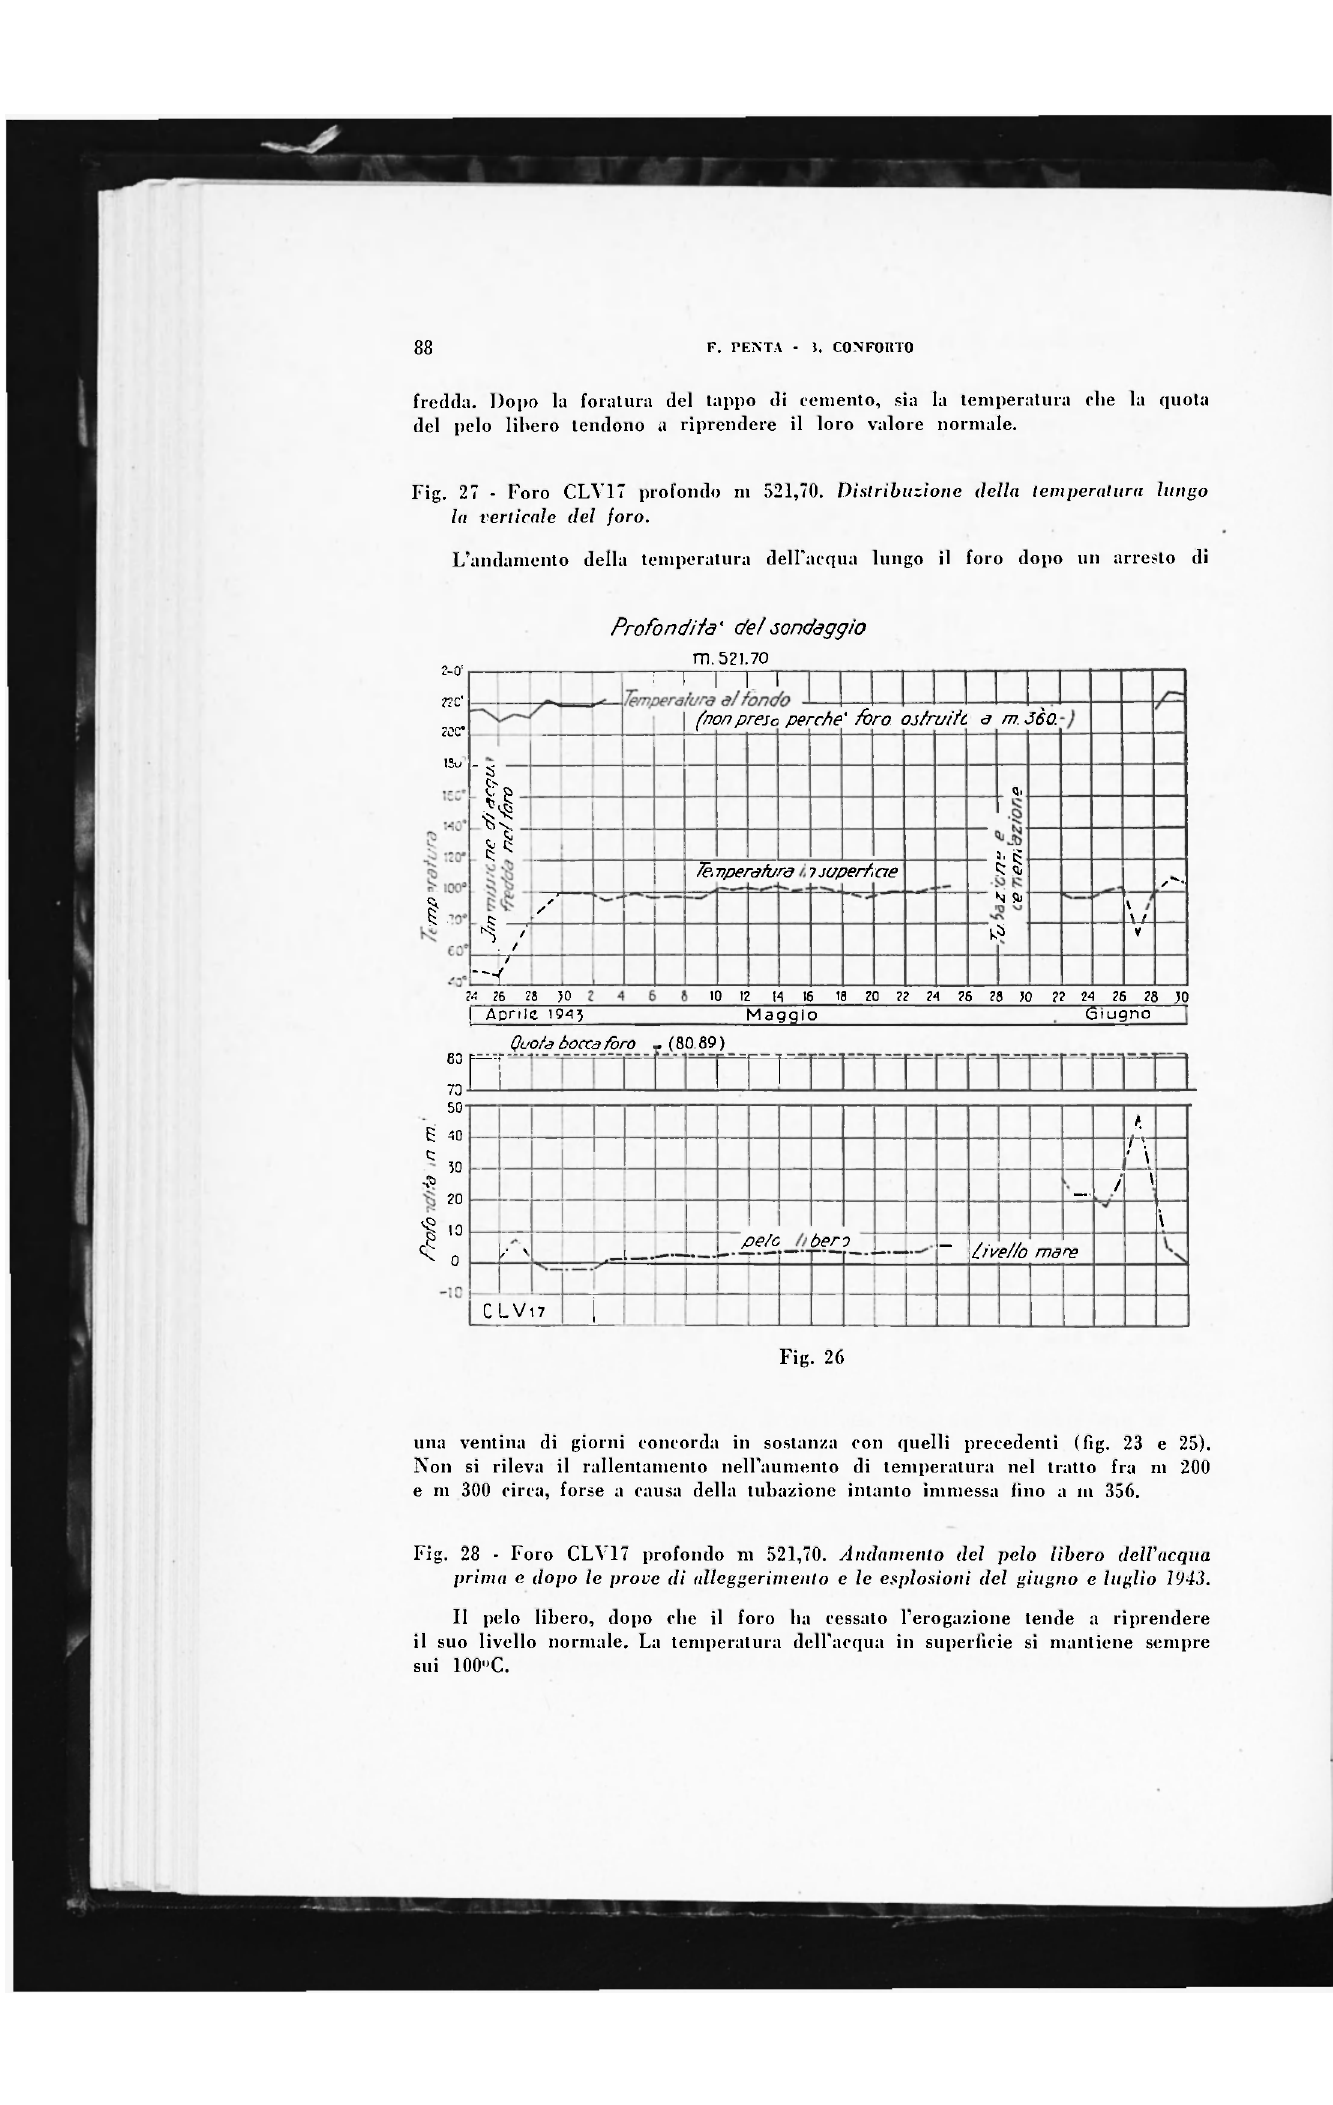
Fig. 27 - Foro CLY17 profondo m 521,70. Distribuzione della temperatura lungo la verticale del foro.